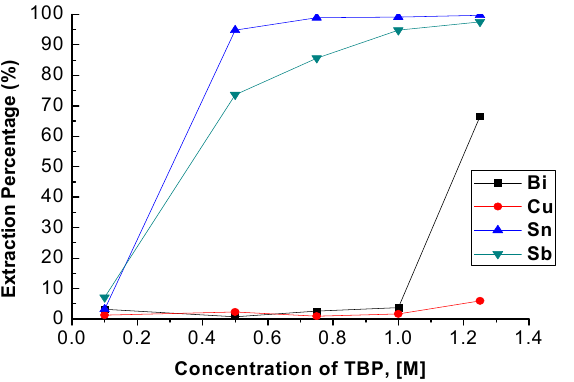
Figure 3. Extraction percentage of metals at different concentrations of TBP. (HCl) = 4 M, O/A ratio = 1, reaction time = 5 min.